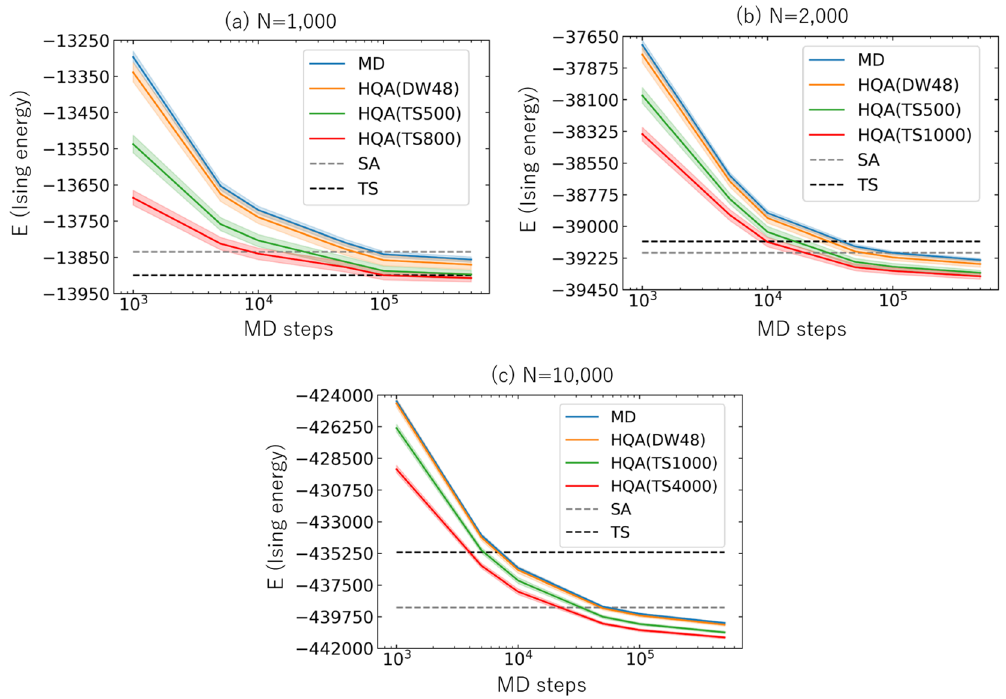
Figure 7. Results of the Ising energy E for the Ising spin-glass problem averaged over 100 instances by using different solvers with three different system sizes ( a ) N = 1000 , ( b ) N = 2000 , and ( c ) N = 10,000